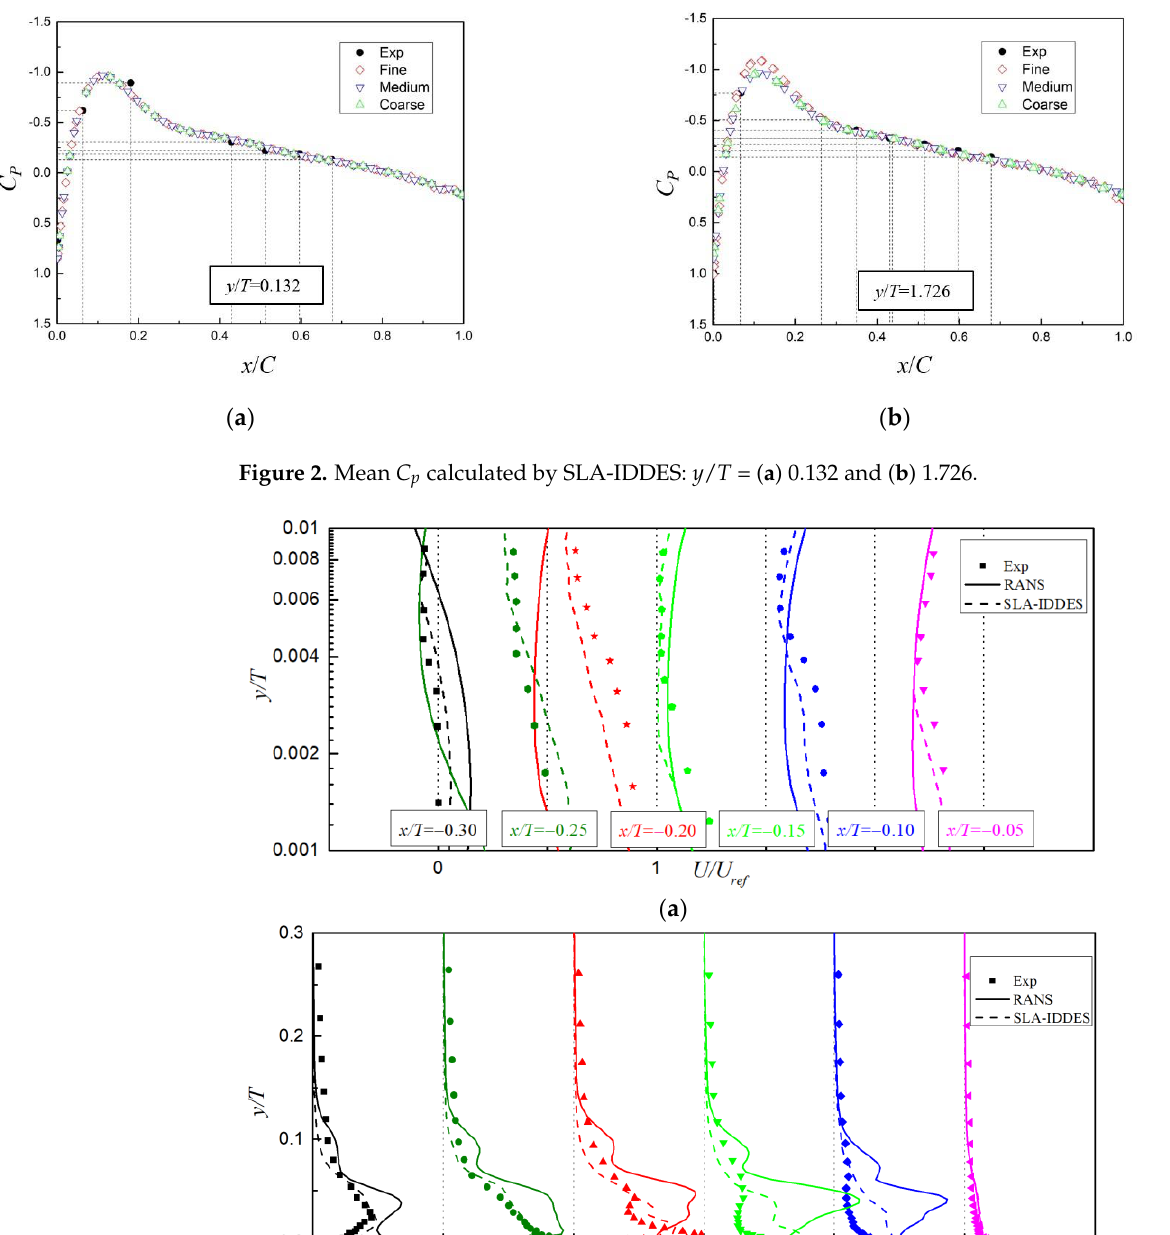
Figure 3. Mean velocity profile and Reynold stress in the leading edge region calculated using three different methods: ( a ) velocity profile and ( b ) Reynold stress.